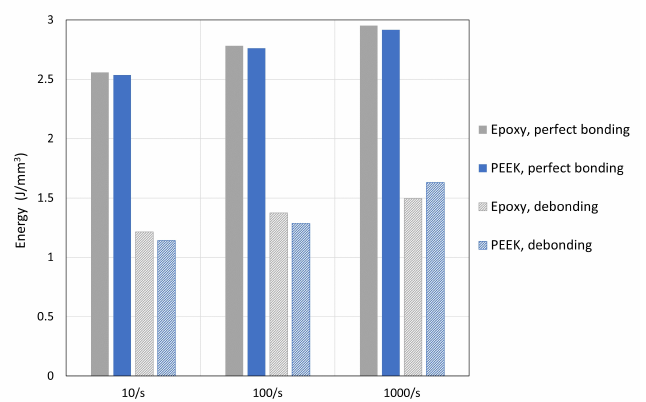
Figure 19. Energy per unit volume in both material systems under different strain rates with and without fibre–matrix debonding.